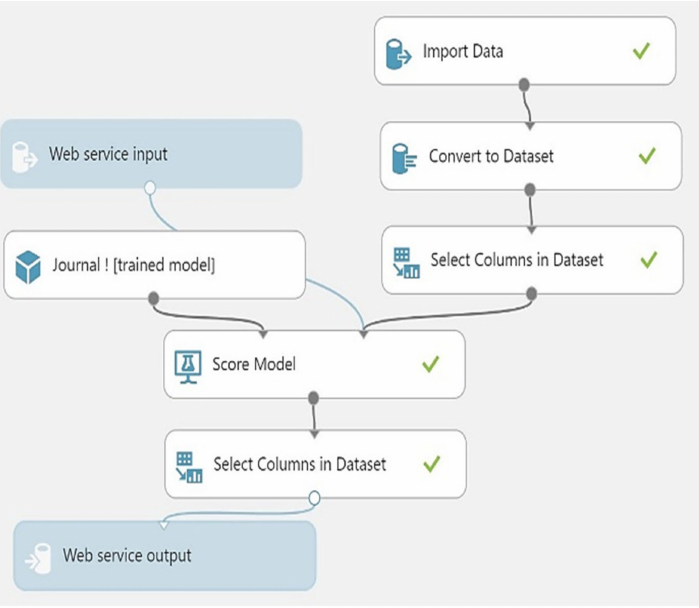
√ ’ sign denotes the